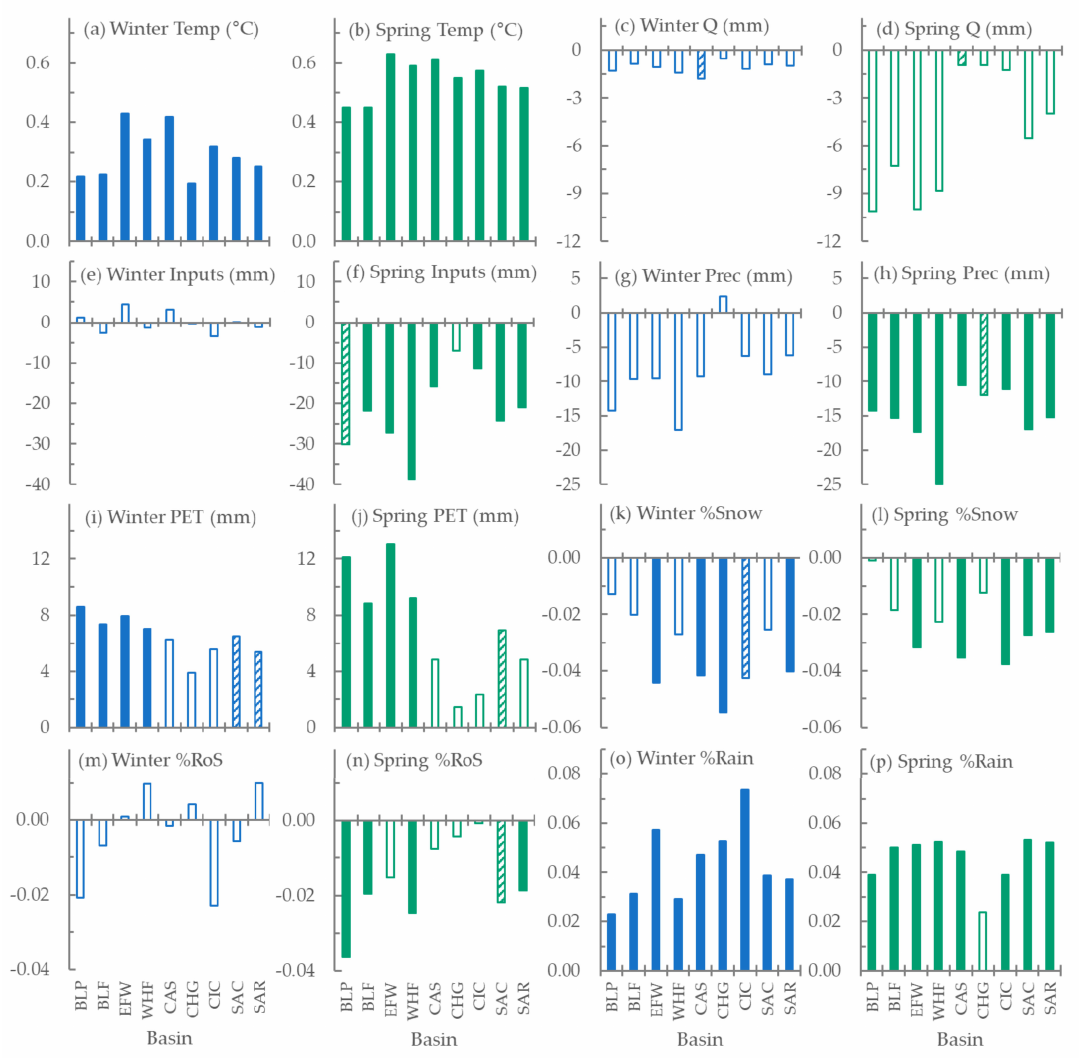
Figure 5. Decadal trend slopes from 1968–2011 in winter and spring: temperatures ( a , b ); streamflow, (Q) ( c , d ); hydrological inputs (sum of snowmelt, rain-on-snow and rainfall) ( e , f ); total precipitation ( g , h ); potential evapotranspiration, PET ( i,j ); percent snowmelt ( k,l ); percent rain-on-snow, RoS ( m , n ); and percent rainfall ( o , p ) in Salt River basins. Units of y-axes are shown in sub-figure headings ( a – p ). Trends were calculated using the Mann-Kendall test [42,43], trend slopes calculated using Sen’s slope estimation [45]; filled bars show trends significant at p < 0.05; stripped 0.05 < p < 0.1; and empty bars p > 0.1. Precipitation from [34]; hydrological inputs from model developed in this study; PET from TerraClimate